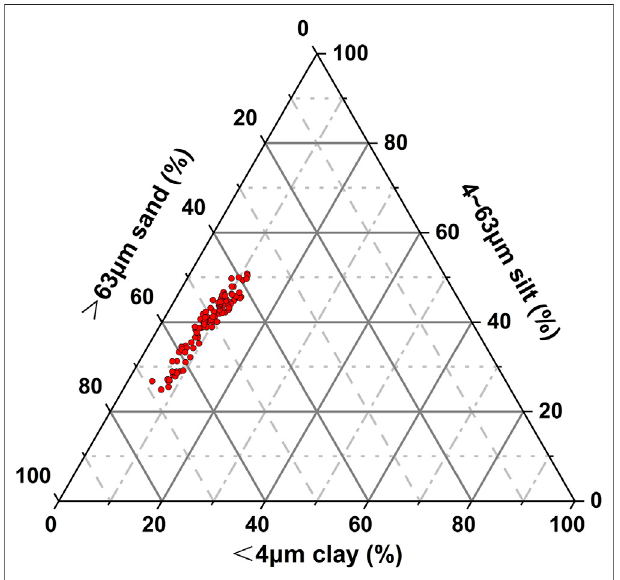
FIGURE 4 | Ternary diagram showing grain size components for samples from the NJ section.